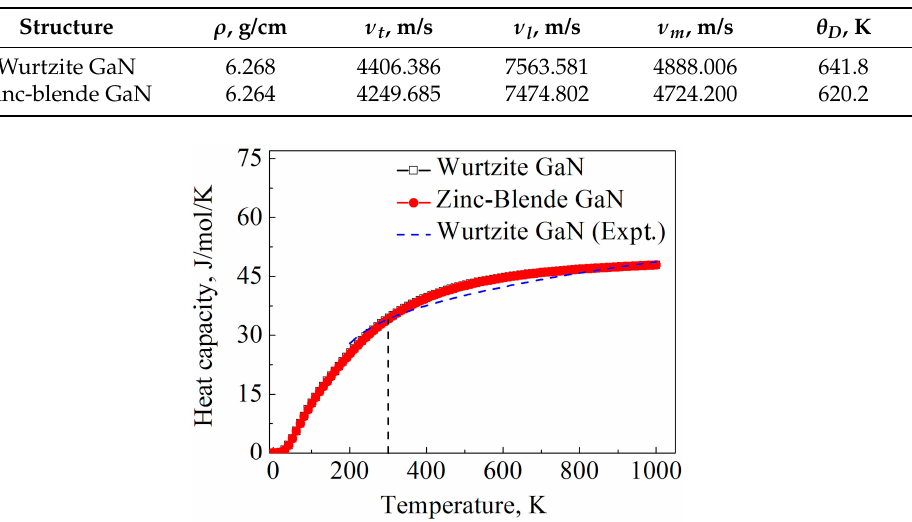
Figure 5. Calculation results of temperature-dependent heat capacities for wurtzite and zinc-blende GaN. The dash line denotes experimental data of wurtzite GaN obtained from Ref. [62].